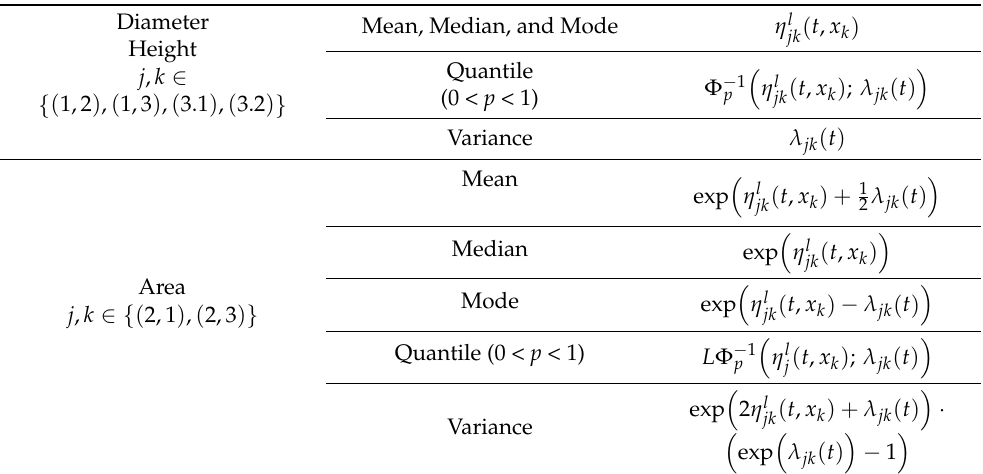
Table A2. Conditional mean, median, mode, p-quantile (0 < p < 1), and variance trends with one